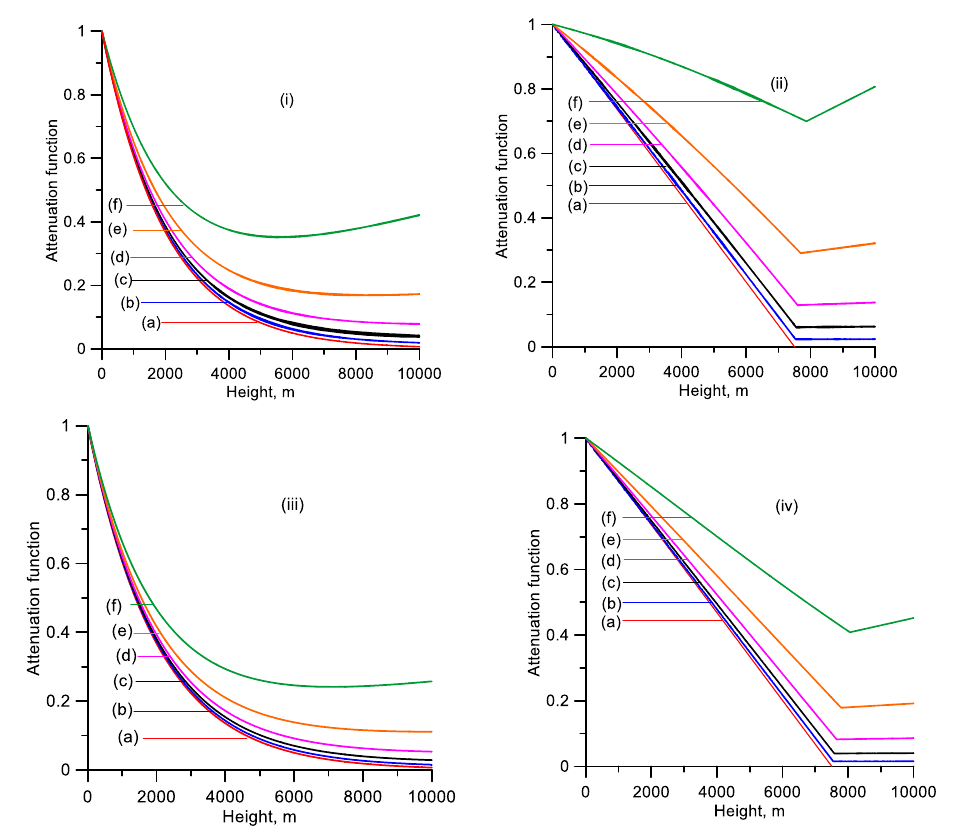
Figure 3. Attenuation functions derived from the electric field at different distances. ( i ) MTLE model, first strokes; ( ii ) MTLL model, first strokes; ( iii ) MTLE model, subsequent strokes; ( iv ) MTLL model, subsequent strokes. (a) Pure radiation, (b) 500 km, (c) 200 km, (d) 100 km, (e) 50 km, (f) 25 km.